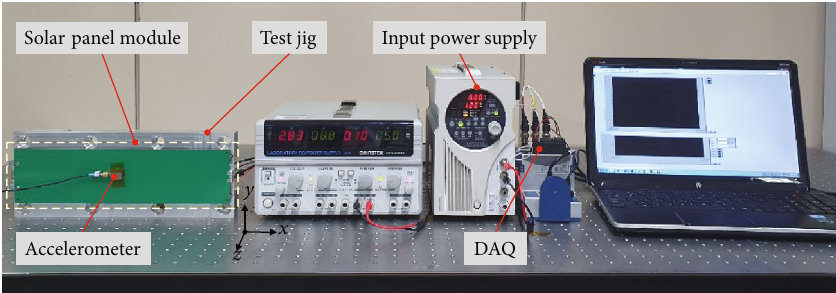
Figure 7: Release function test setup of the demonstration model of the 3U solar panel.